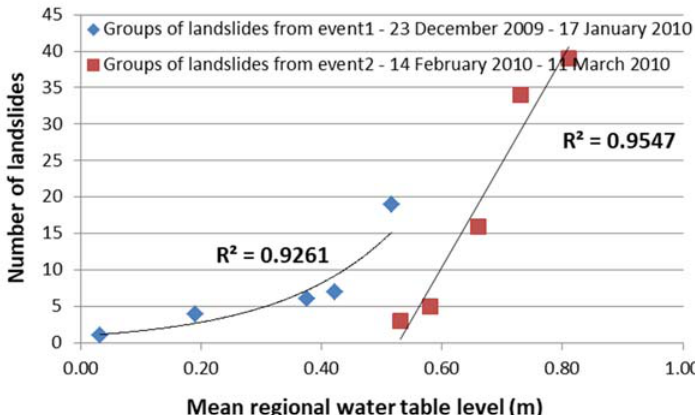
Figure 6. Number of recorded landslides against estimated mean regional water table level for two instability events during the ascending phase of the water table (cf., Figure 5) that occurred in the hydrological year 2009/10 in the GPR basin. Given that landslide recordings were not acquired in regular intervals these were reorganized in groups of five consecutive days and compared to the mean value of regional water table for that specific period.